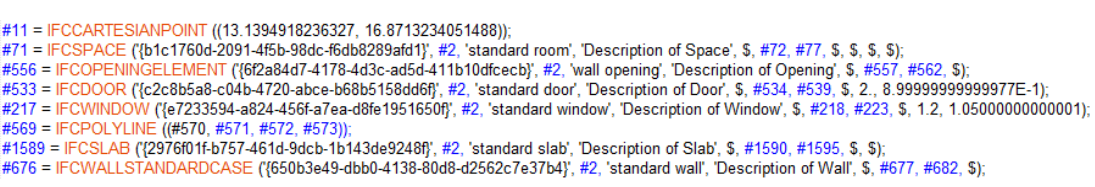
Figure 3. General procedure of the detection process of architectural components. ( a ) The first part of the procedure performs the generation of the graph and the detection of openings and adjacent walls.; ( b ) In the second phase the user can verify and adjust the result before rooms and outside areas are detected. Finally the IFC objects are exported.